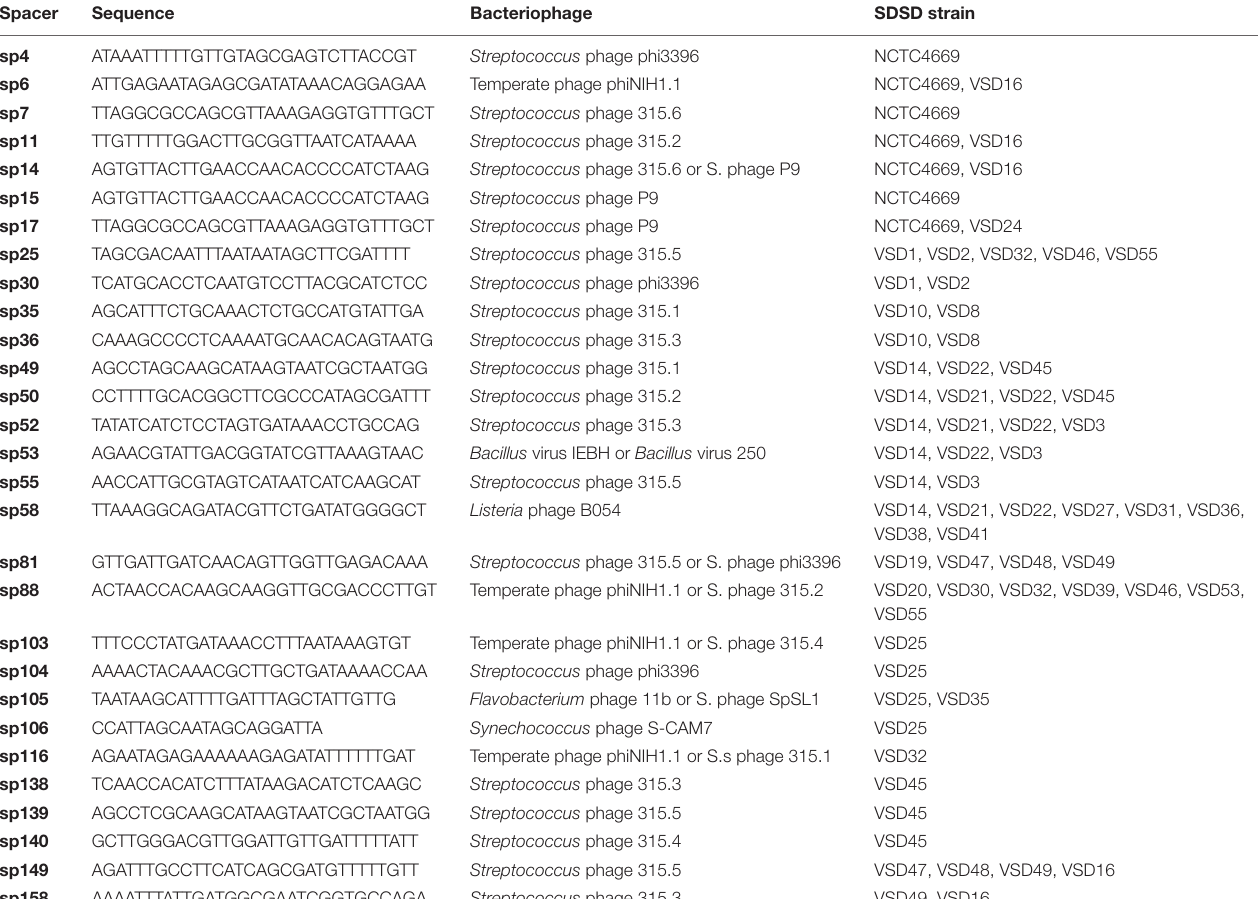
TABLE 2 | Identification and nucleotide sequence of the bacteriophage spacers in a CRISPR array of SDSD.